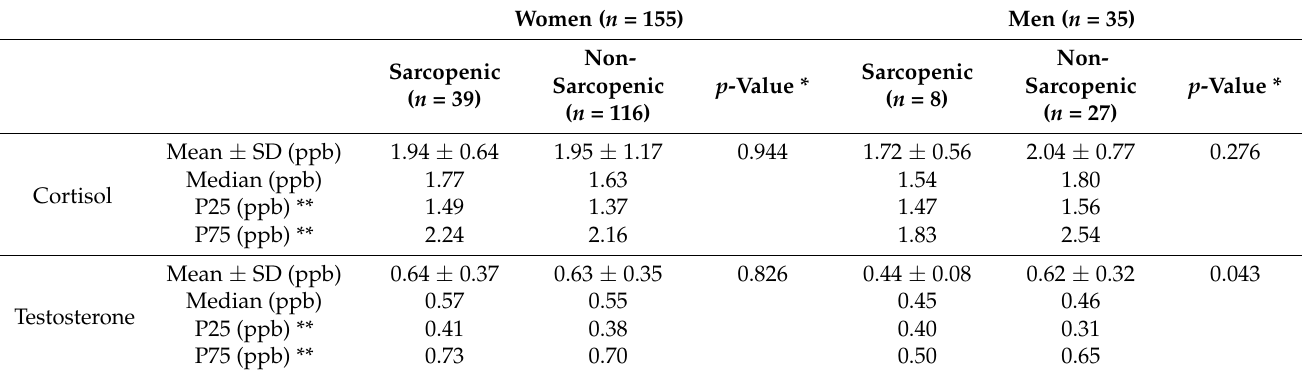
Table 4. Descriptive values for salivary cortisol and testosterone by sarcopenic status.